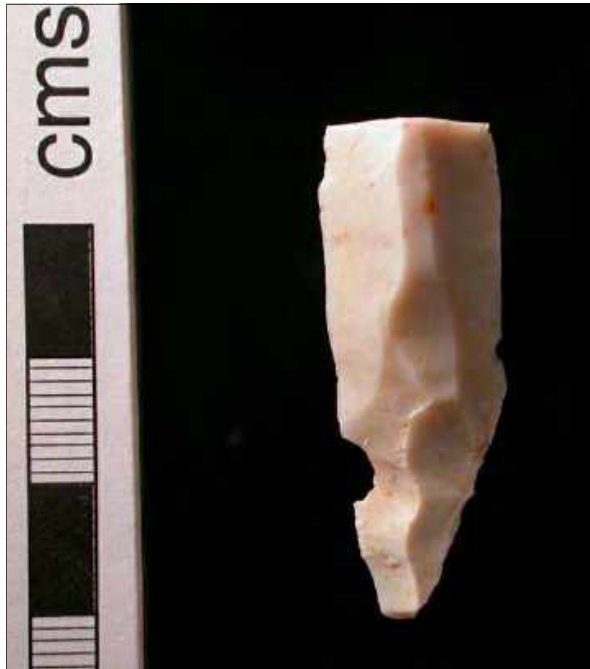
Fig 2.5 Notched flint bladelet from Weaverham, Cheshire (Portable Antiquities